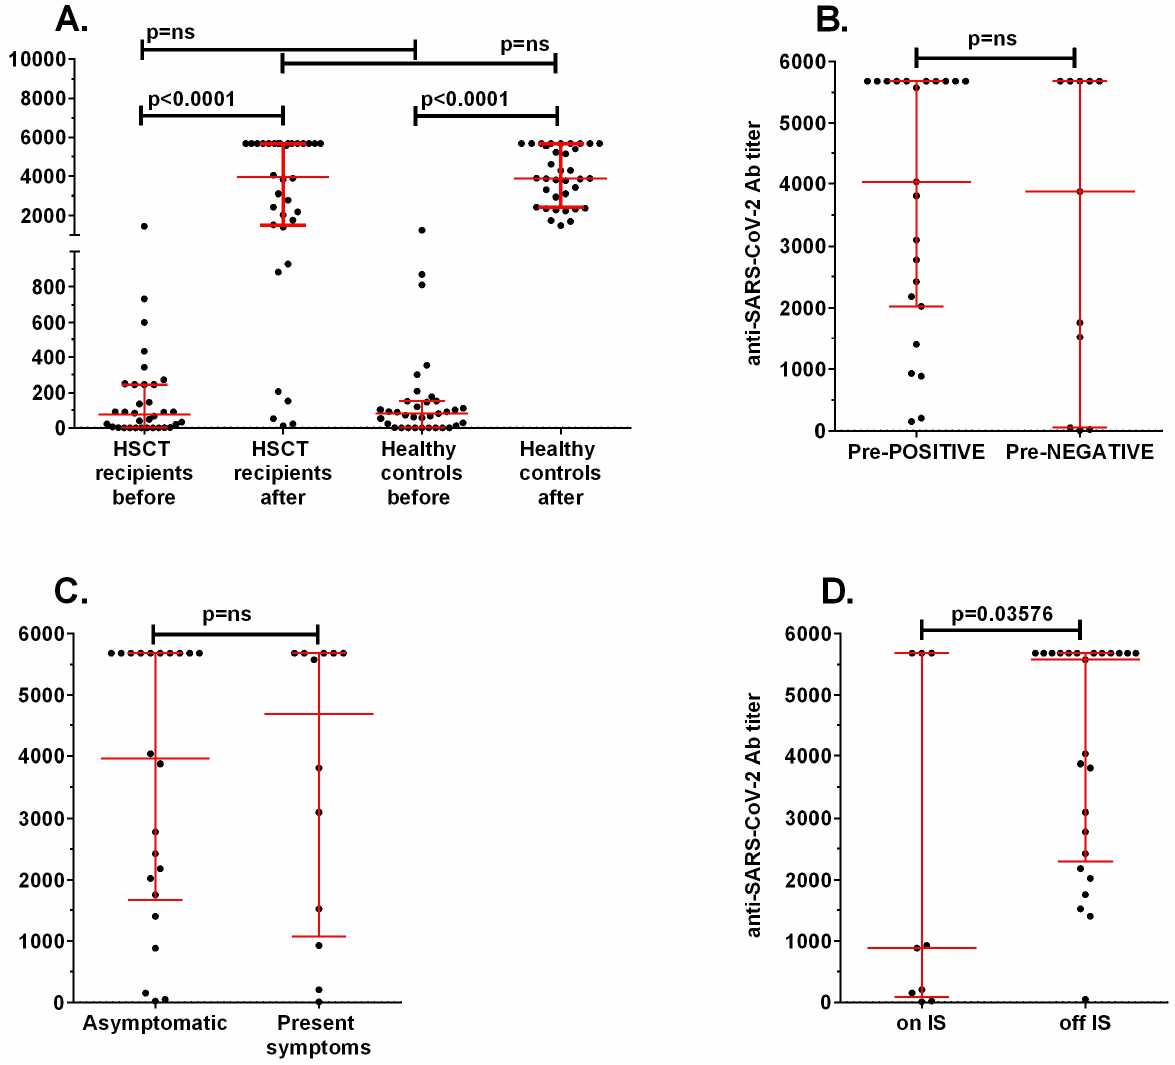
Figure 3. Comparison of the concentration of anti-SARS-CoV-2 specific antibodies in ( A ) HSCT recipients and healthy controls before and after vaccination, ( B ) patients positive before the first dose (Pre-POSITIVE) versus negative (Pre-NEGATIVE), ( C ) patients showing vaccination-associated symptoms and those who were asymptomatic, and ( D ) patients on immunosuppressive treatment (on IS) and those off of treatment (off IS). ns: non-significant.